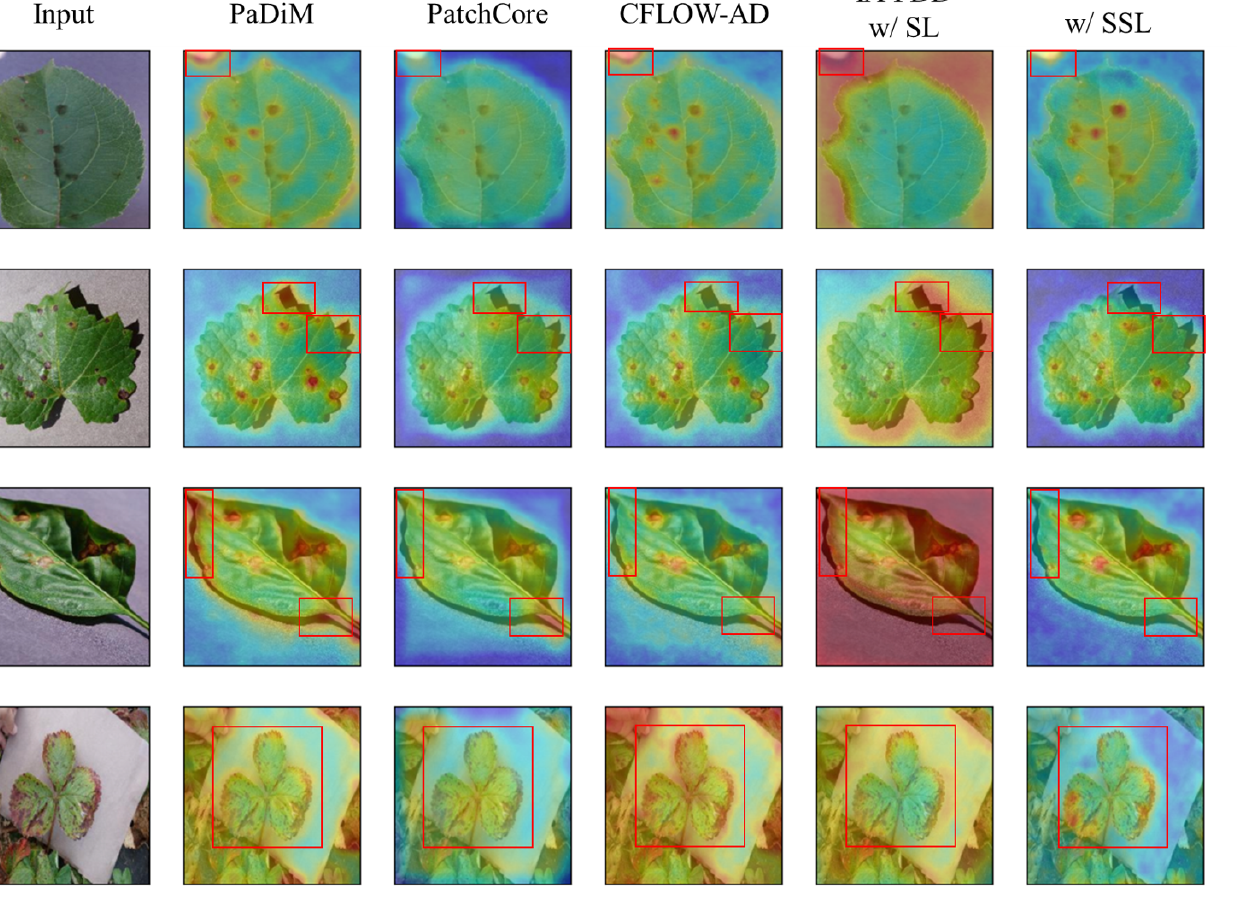
Figure 5. Qualitative results of ablation study. The first two rows from the top are example cases of background noise; the two rows from the bottom correspond to example cases of unstructured data. We indicate areas where diseases are found with red